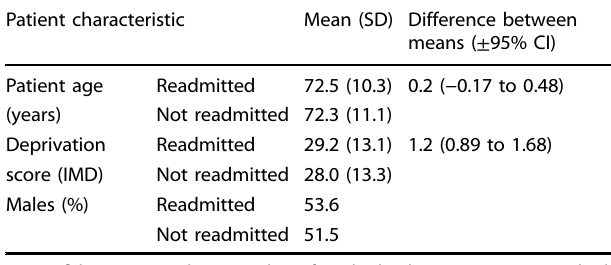
Table 1. Comparison between patients who were readmitted with COPD within 1 year (6295) of the index COPD admission and those patients who were not readmitted within 1 year (13,256), 2006 – 2010 Patient